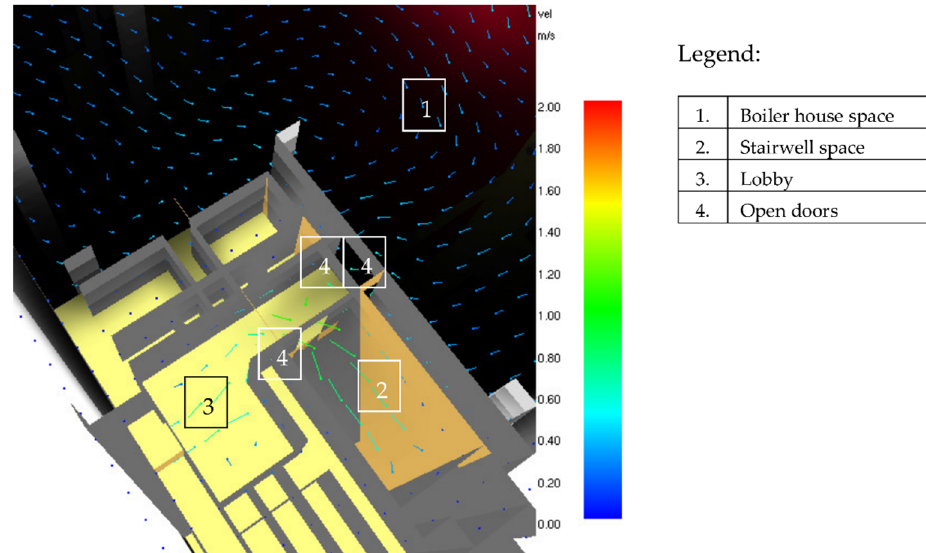
Figure 13. Vestibule and stairwell smoke protection under the boiler room fire conditions when the vestibule–boiler room and vestibule–stairwell doors are open. 6.4. The Overpressured Stairwell with a Ventilated Vestibule in Nonventilated Boiler House The final simulation represents the same door opening conditions as in Figure